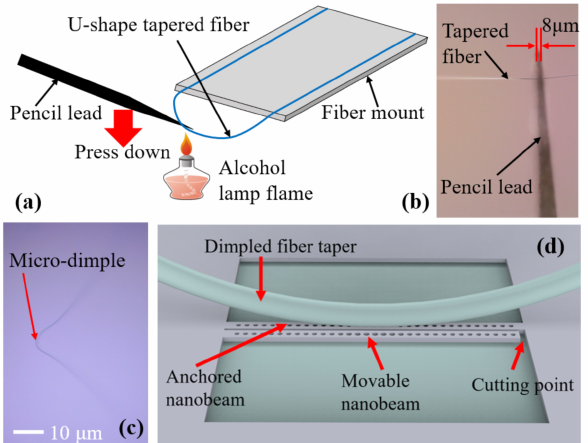
Figure 3. Dimpled tapered fiber fabrication and evanescent coupling method. ( a ) Dimpling process; ( b ) microphotograph of the polished wedge-shaped pencil lead pressing against the tapered fiber; ( c ) microphotograph of the dimple at the center of U-shape tapered fiber; ( d ) schematic diagram of near-field coupling position between fiber taper and PCN cavity.